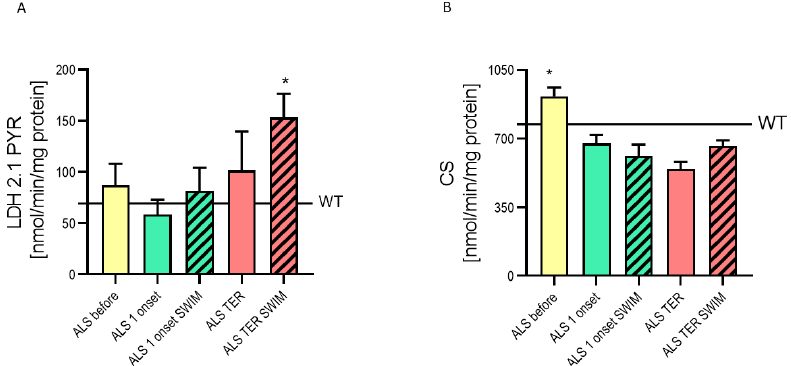
Figure 2. Oxidative and glycolytic enzyme activities in the spinal cord: ( A ) LDH 2.1 PYR activity, WT= 69.5 ± 19.4 nmol/min/mg protein, * p < 0.005 versus WT, ALS before and ALS 1 onset groups (WT n = 7/8, ALS before n = 7/8, ALS 1 onset n = 7/8, ALS 1 onset SWIM n = 5/7, ALS TER n = 5/10, ALS TER SWIM n = 9/10). ( B ) CS activity, WT= 773.3 ± 54.1 nmol/min/mg protein, * p < 0.05 versus the rest of the ALS groups (WT n = 8/8, ALS before n = 8/8, ALS 1 onset n = 7/8, ALS 1 onset SWIM n = 6/7, ALS TER n = 7/10, ALS TER SWIM n = 10/10). LSD post hoc tests after one-way ANOVA was used for all figures.